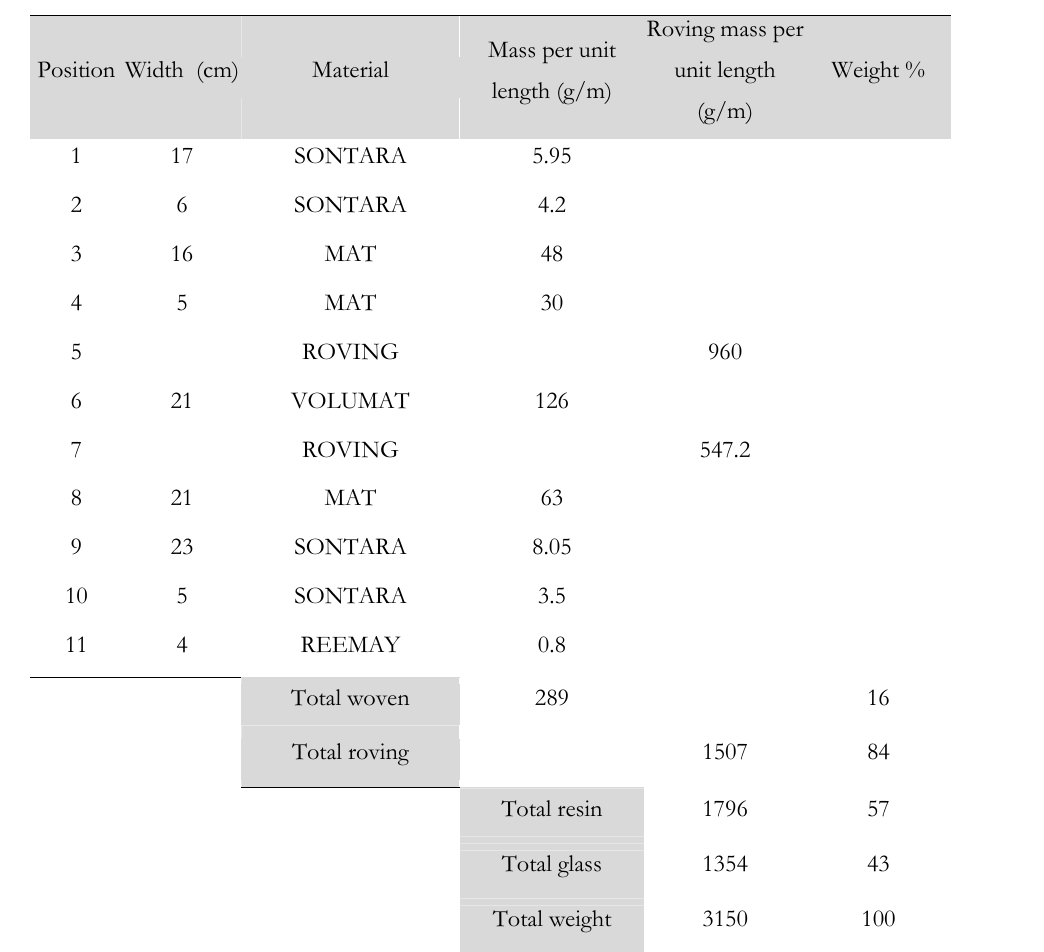
Table 1: Chemical composition of the layers of the pultruded material (the position refers to Fig. 1).